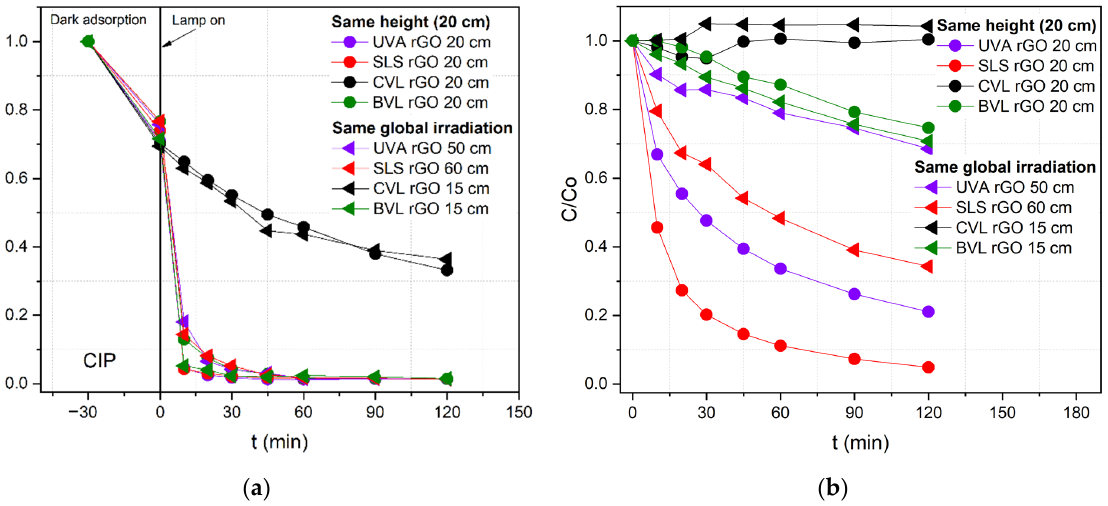
Figure 9. CIP removal by ( a ) photocatalyst N/TiO 2 /rGO with 0.25 wt.% of rGO and by ( b ) photolysis with lamps located at two different distances from the reactor.